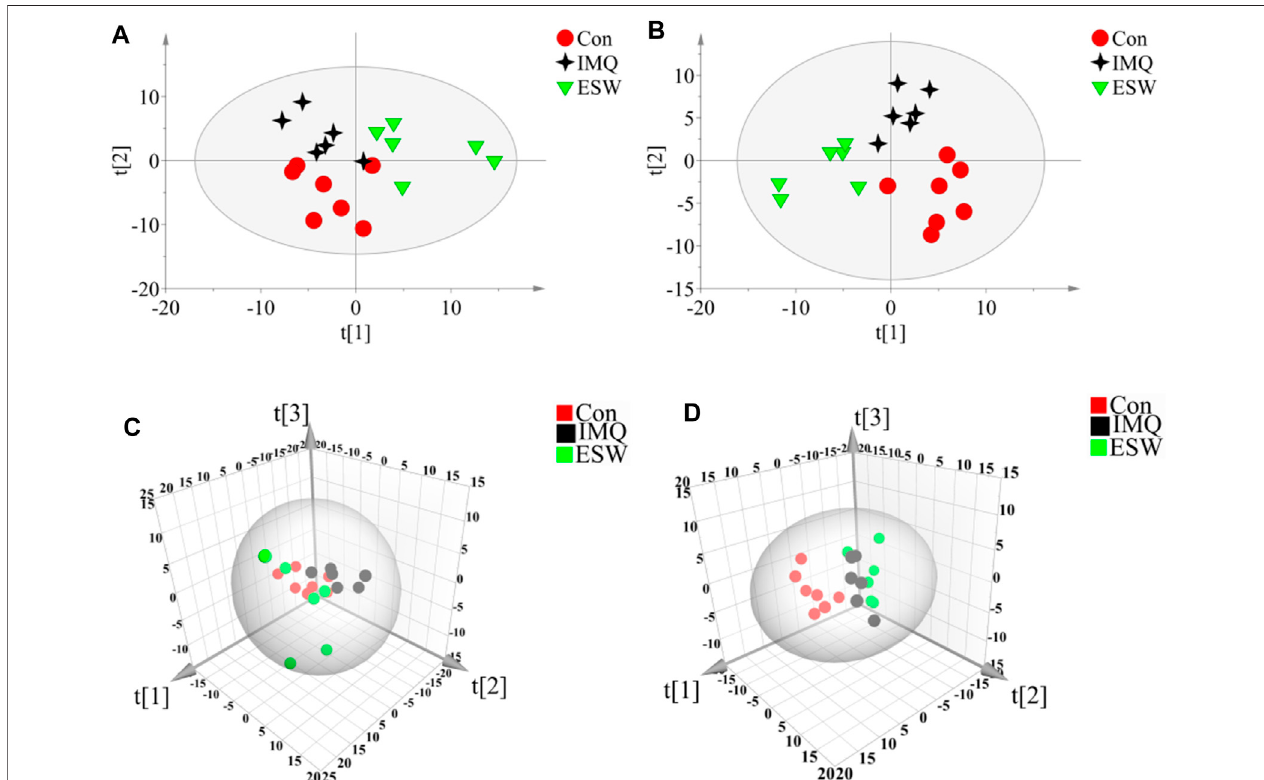
FIGURE 5 | PCA and PLS-DA scores plots of mouse serum data in Con group, IMQ group, and ESW group. (A) Dynamic mean-centered PCA 2D score plot of mouseserumdata. (B) Dynamicmean-centeredPLS-DA2Dscoreplotofmouseserumdata. (C) Dynamicmean-centeredPCA3Dscoreplotofmouseserumdata. (D) Dynamic mean-centered PLS-DA 3D score plot of mouse serum